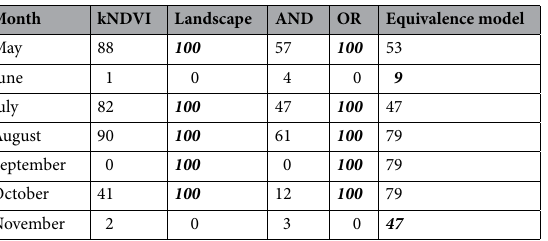
Table 2. Simulation results of the number of “correct” for each model. In total, 100 runs were conducted for each simulation. The best performance for each month is highlighted by bold italic text.